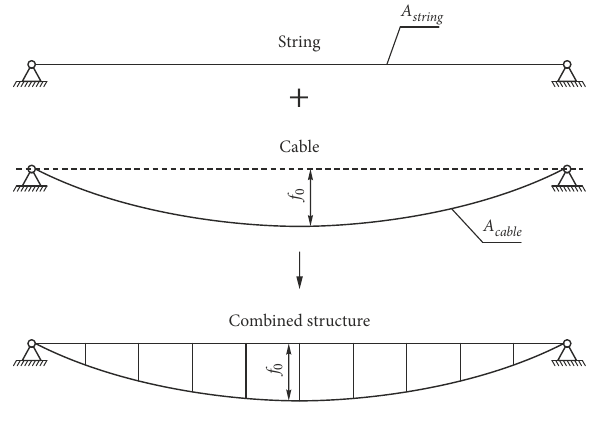
Figure 1. Combined string structure